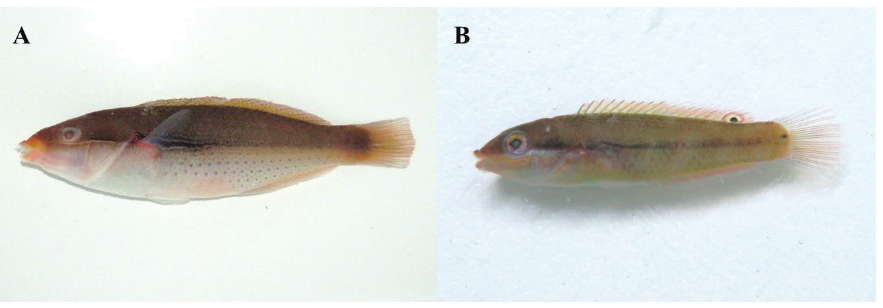
Figure 9. A Stethojulis interrupta terina , MFD-850, 92.9 mm SL B Stethojulis trilineata , MFD-482, 25.7 mm SL.